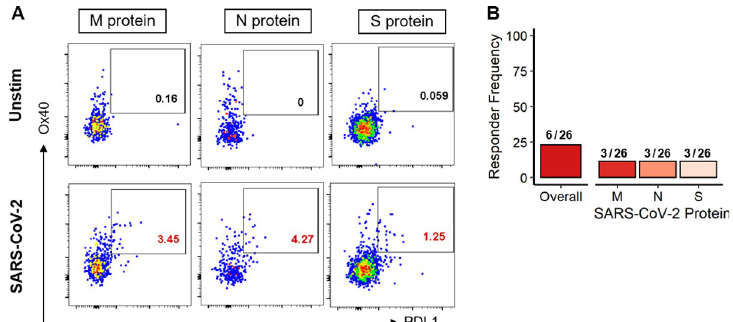
Fig 2. SARS-CoV-2-specific circulating T follicular helper cells are detected at the first visit in 6 out of 26 convalescent individuals. (A) Representative examples of antigen-specific cTfh (CD4 + CXCR5 + PD1 + ) detected upon stimulation with SARS-CoV-2 M, N, and S protein peptides for Visit 1 in three individuals (CID8, CID11, and CID13, respectively). Negative control of unstimulated cells shown in the top row. (B) Frequency of individuals mounting a positive cTfh response at their first visit to any SARS-CoV-2 protein and to the M, N, and S protein peptide pools.